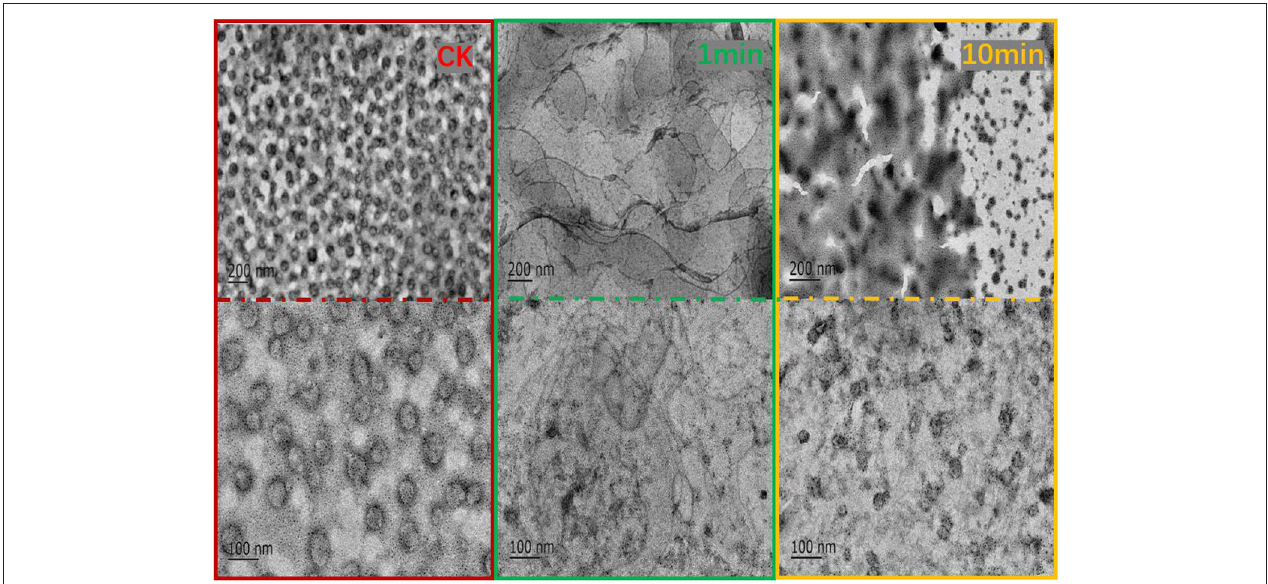
FIGURE 5 | TEM observation of the effect of antibacterial peptide F1 on phospholipid membrane at 1 and 10min.